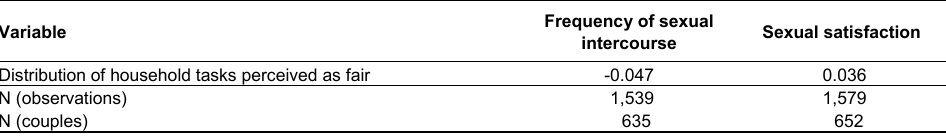
Table A.11 : Summary of fixed effects regression analyses estimating frequency of sexual intercourse and sexual satisfaction (only female partner’s report)